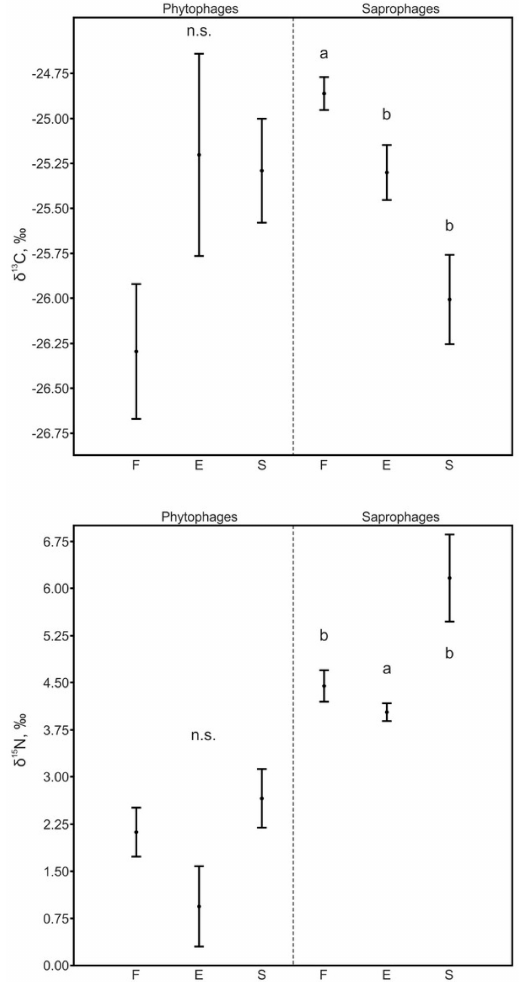
Figure 3. Mean ( ± 1 SE) δ 13 C (top) and δ 15 N (bottom) values of phytophages and saprophages in the forest, forest edge, and steppe habitats. Significantly ( p < 0.05) different values are indicated by different letters (a, b). n.s. – no significance. F: forest, E: edge, S: